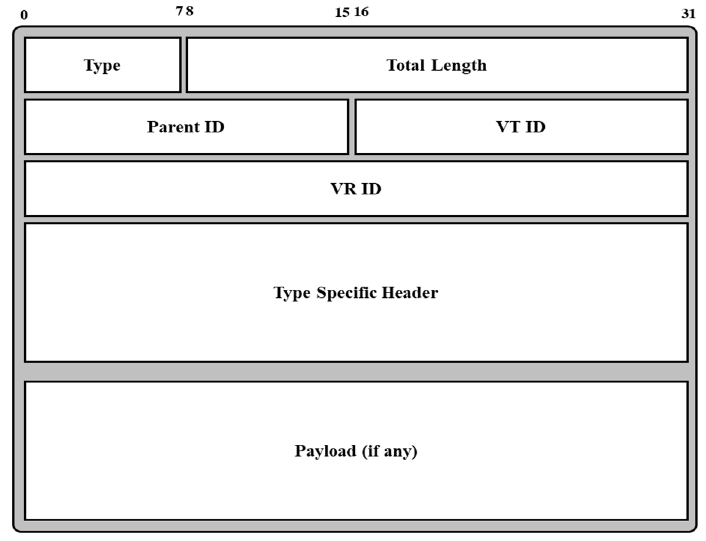
Figure 5. VIP packet format.